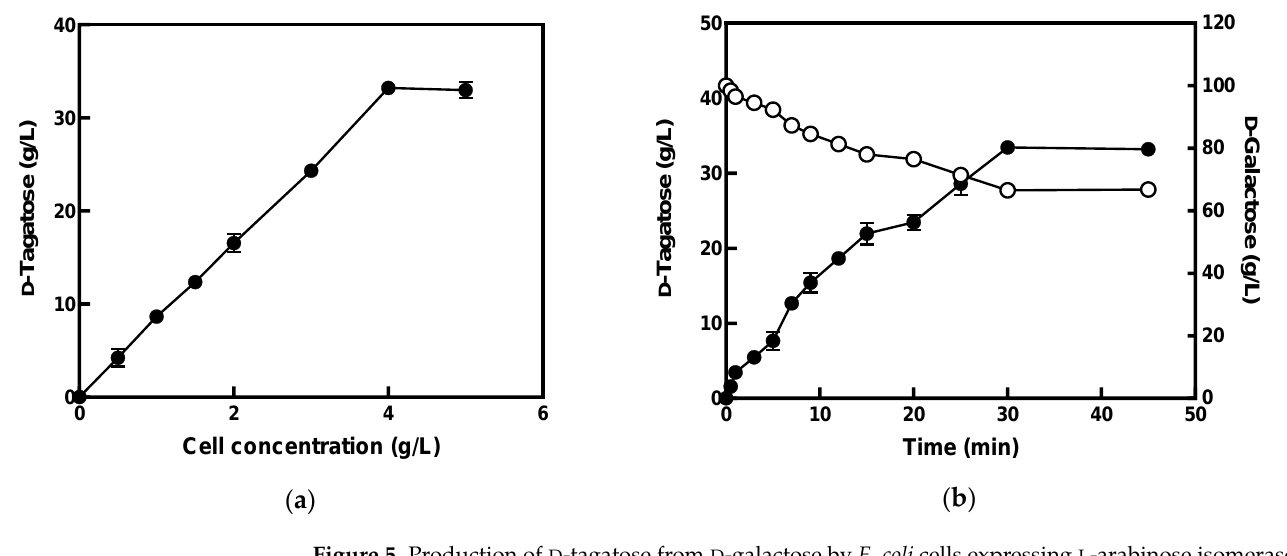
Figure 5. Production of D -tagatose from D -galactose by E. coli cells expressing L -arabinose isomerase from K. pneumoniae. ( a ) Effect of the concentration of E. coli cells expressing L -arabinose isomerase from K. pneumoniae on D -tagatose production. The reactions were performed in 50 mM phosphate buffer (pH 8.0) containing 100 g/L D -galactose at 50 ◦ C with varying concentrations of cells from 0.5 to 5 g/L. ( b ) Time-course reactions for the production of D -tagatose (black circle) from D -galactose (white circle) by E. coli cells expressing L -arabinose isomerase from K. pneumoniae . The reactions were performed in 50 mM phosphate buffer (pH 8.0) containing 100 g/L D -galactose and 5 g/L cells at 50 ◦ C. Data represent the mean of values from three experiments, and error bars represent standard